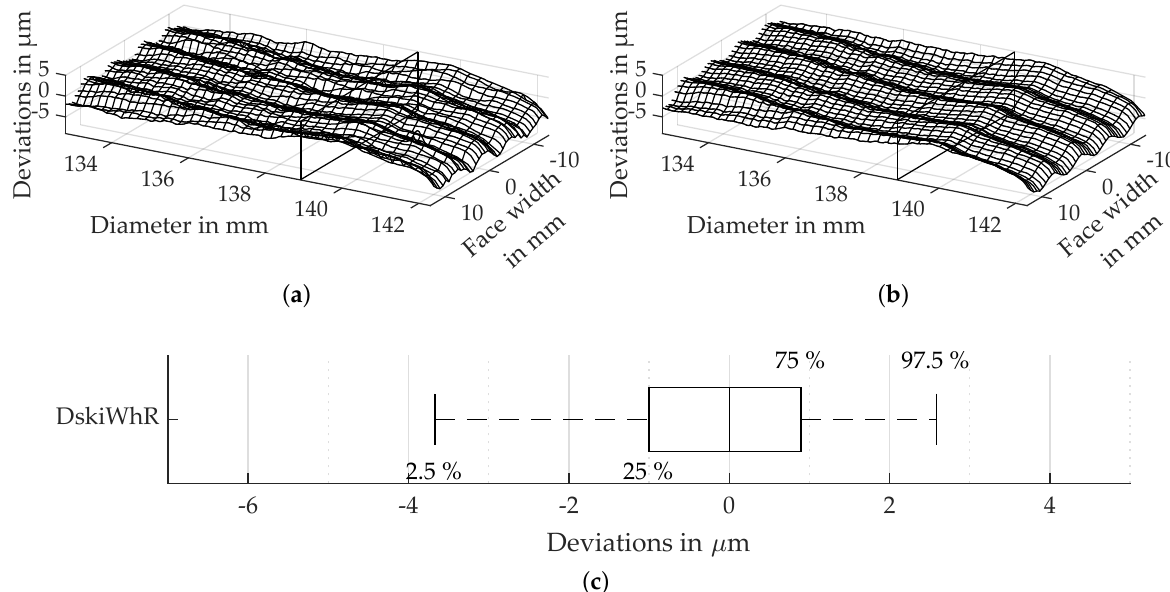
Figure 5. Visualization methods used to show the deviations from the measurement. ( a ) Result of the measurement of a single tooth (DskiWhR at tooth nr. 1). ( b ) Median of the measurement of all teeth of a gear (DskiWhR). ( c ) Box plot of the deviations for all teeth of a gear.